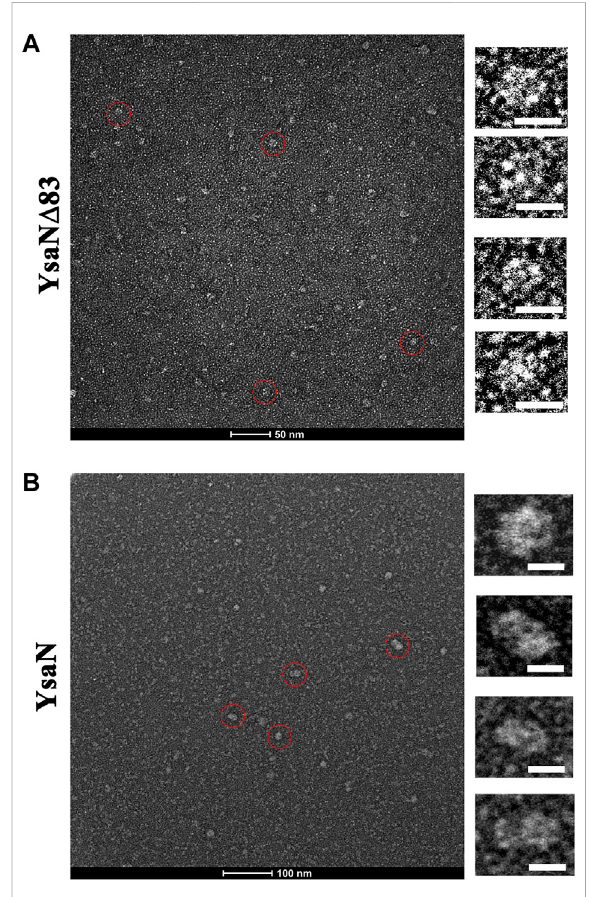
FIGURE 5 Negative TEM image of YsaN and YsaN Δ 83 oligomer in presence of ADP. AlFX. (A) YsaN Δ 83 oligomer. The Zoomed image represents an approximately 10 nm hexamer ring assembly of particlesmarkedbytheredcircleinadifferentorientation. (B) The YsaN higher-order oligomer complex. The zoomed image represents particles marked by the red circle in a different orientation having a size of approximately 15 – 20 nm in different orientations representing probable dodecamer. The prepared sample grids were stained with 1% uranyl acetate. The white color scale bar represents 10 nm in all